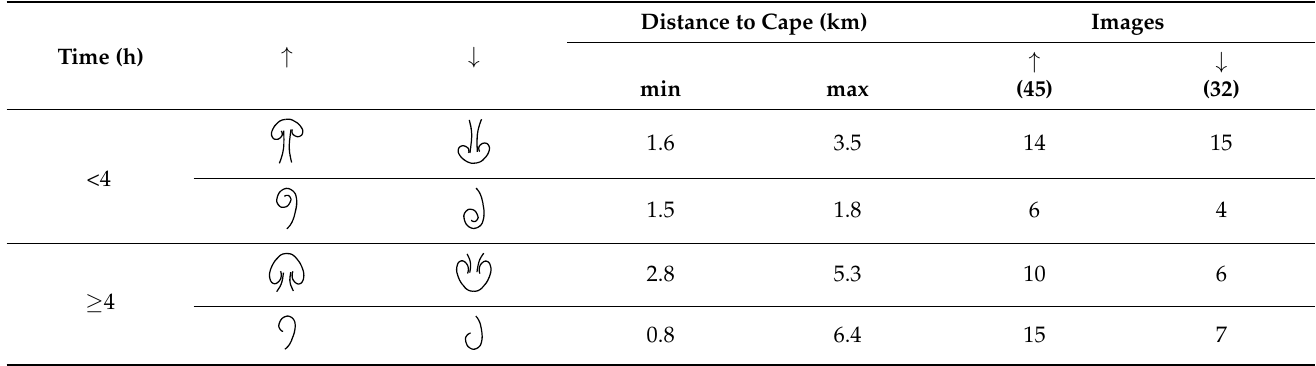
Table 1. Isolated eddies and vortex dipole in Dos Bahías Cape. Time shows the time during which the tidal current had a consistent direction before image acquisition (in hours). Arrows indicate the predominant direction of the tidal current, disaggregated for each type of structure and direction. Distance between structures and Dos Bahías Cape is also indicated. Finally, several images where each structure is observed are included. ↑ ↓ min